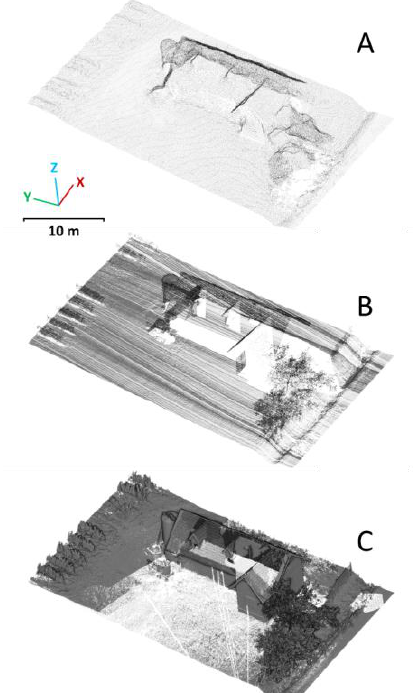
Figure 2. Point cloud derived from different remote sensing methods - (A) close-range photogrammetry, (B) airborne laser scanning (ALS), terrestrial laser scanning